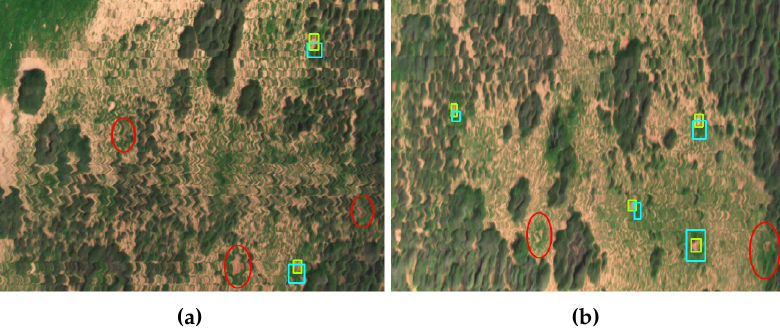
Figure 13. Algorithm outcomes of two ROIs with the remarked missing mounds in red: ( a ) 40% accurate; ( b ) 67%